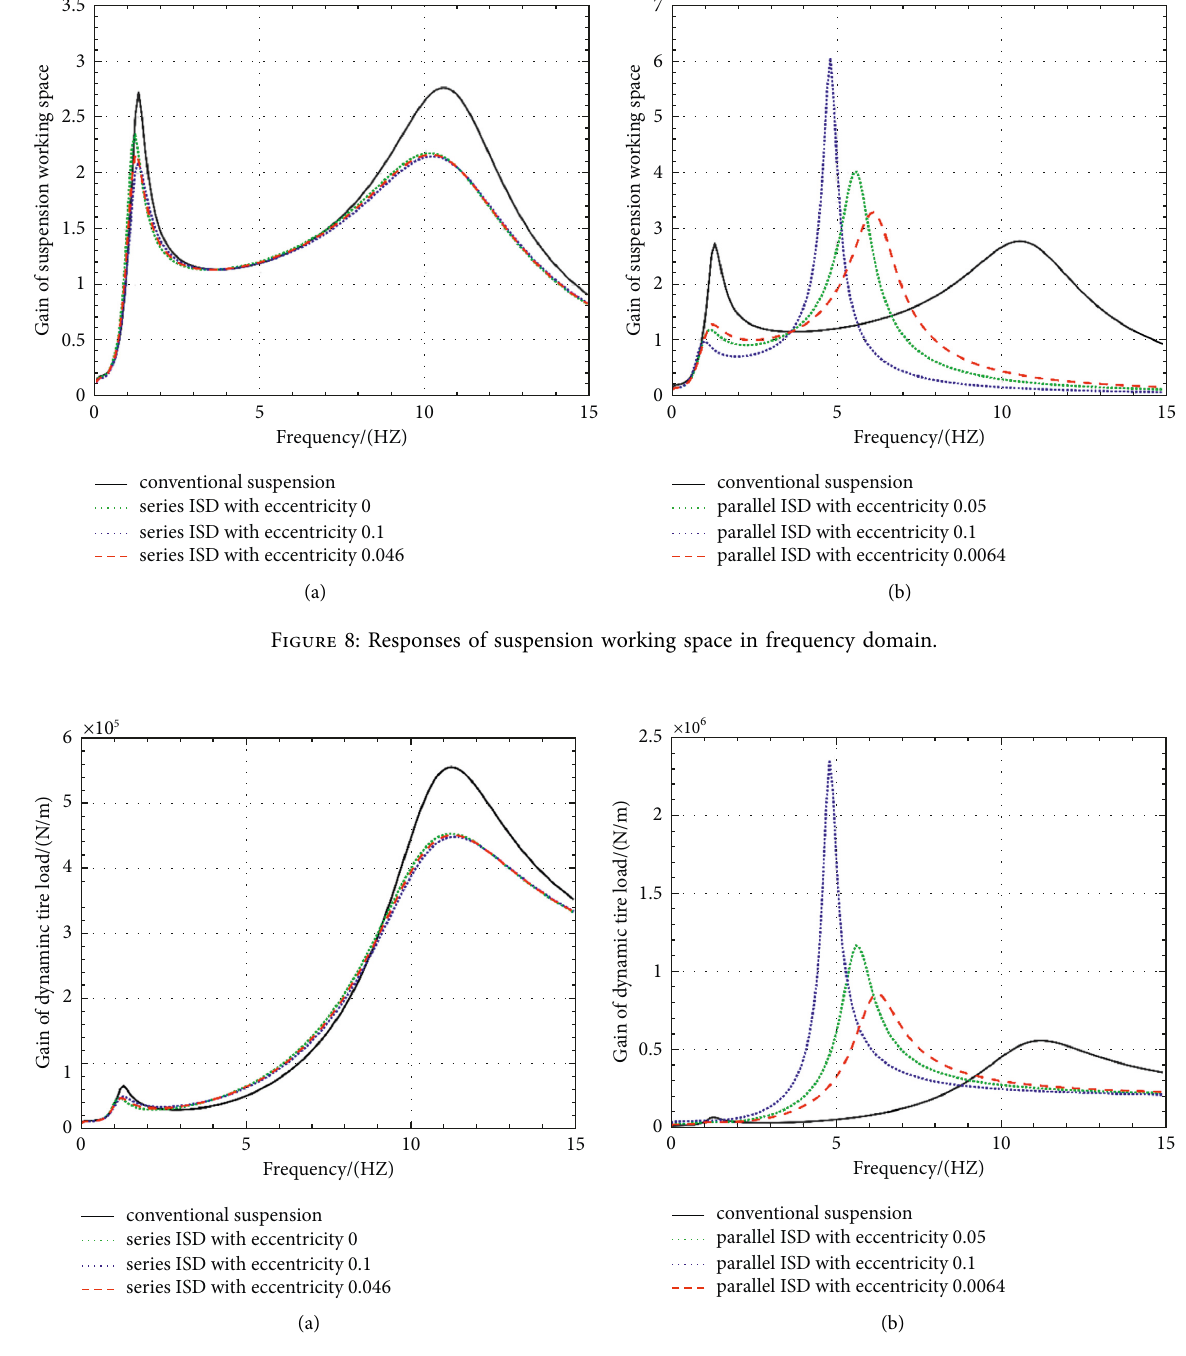
Figure 9: Responses of dynamic tire load in frequency domain. Table 5: Comparisons of peak gain values in frequency domain in a series-connected suspension.